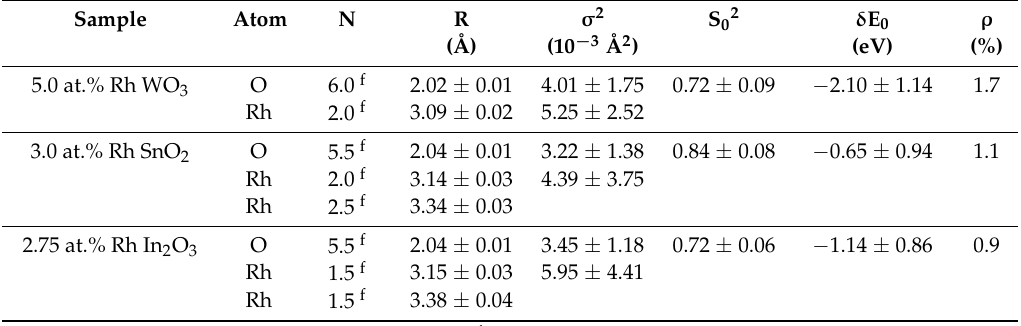
Table 1. Structural parameters obtained from fitted extended X-ray absorption fine structure (EXAFS). Coordination number, N; distance, R; Debye–Waller factor, σ 2 ; energy shift, δ E 0 ; passive electron reduction factor, S 02 ; misfit, ρ .